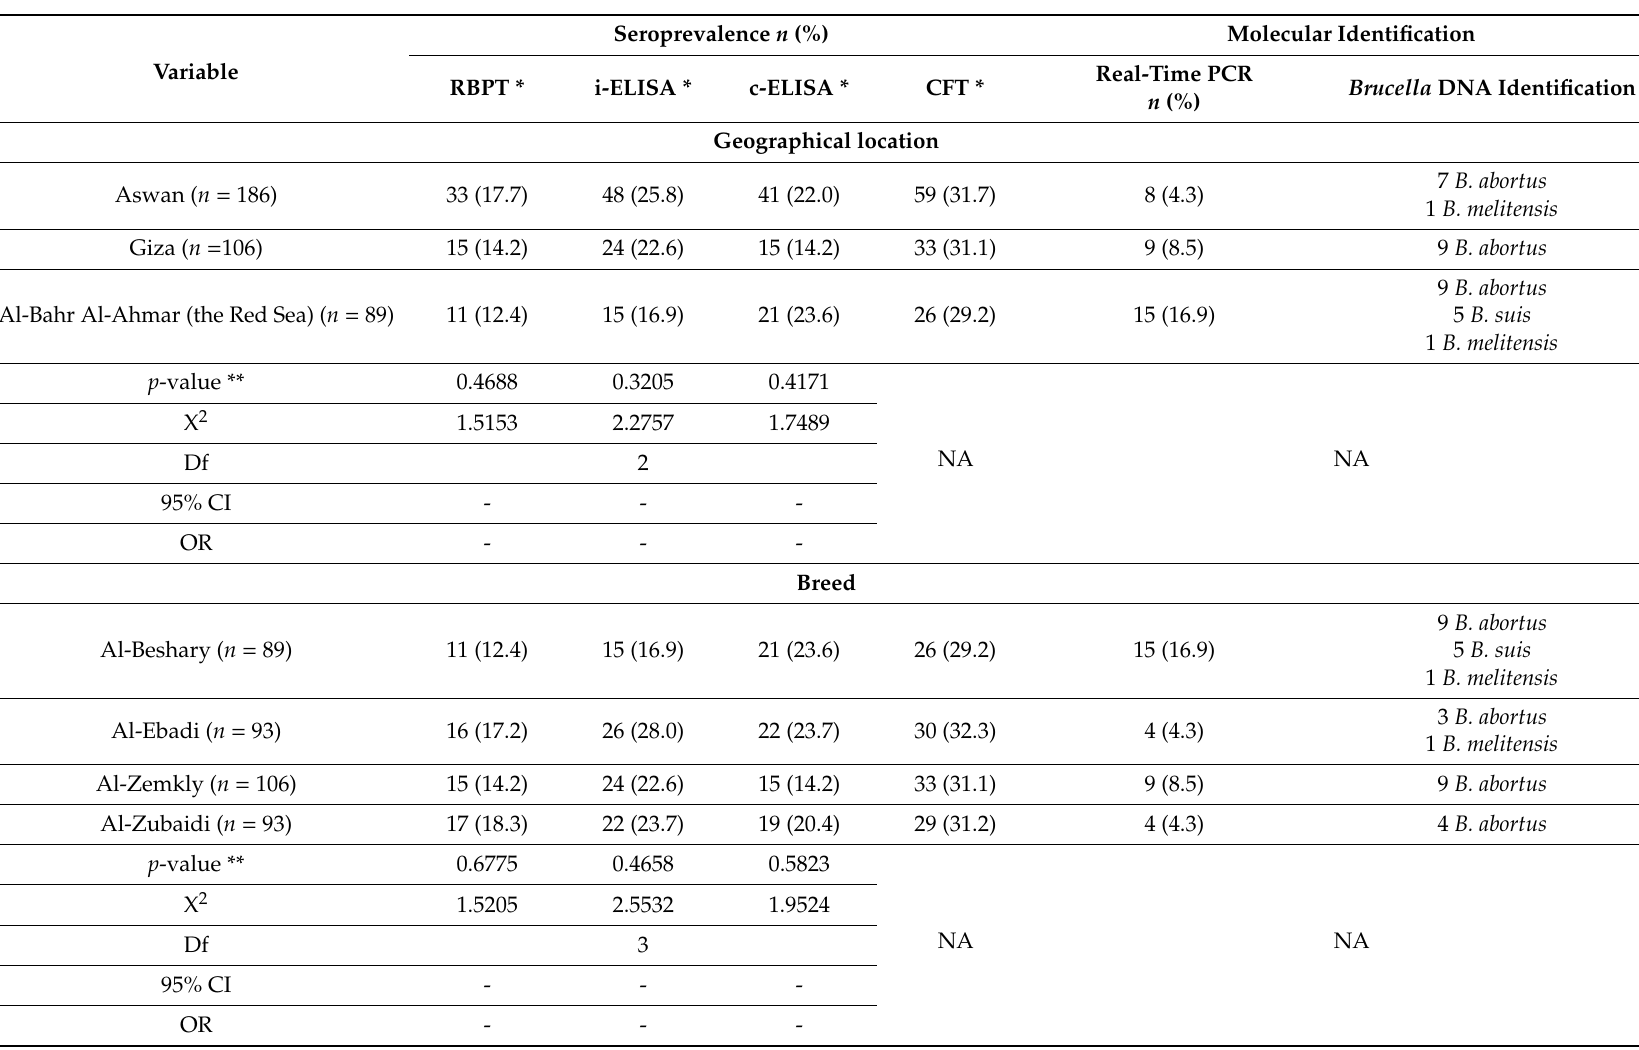
Table 3. Relation of the risk factors with the seroprevalence and molecular detection of brucellosis in 381camels,